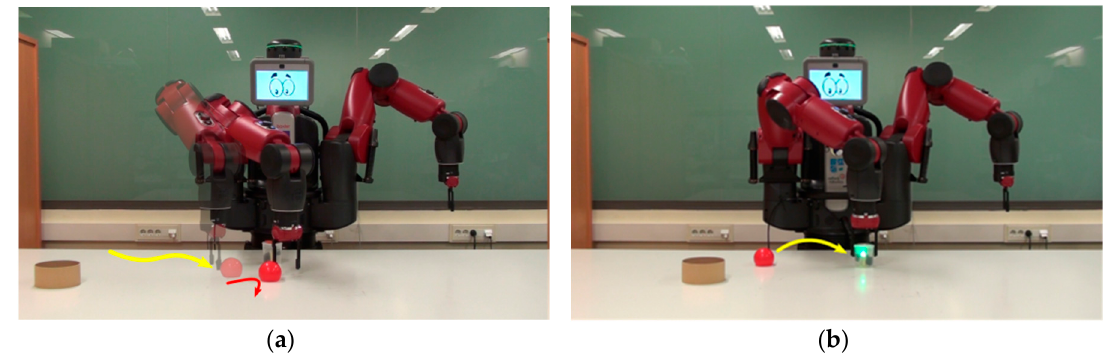
Figure 1. Experimental setup with the Baxter robot. ( a ) Pushing skill; ( b ) Grasping